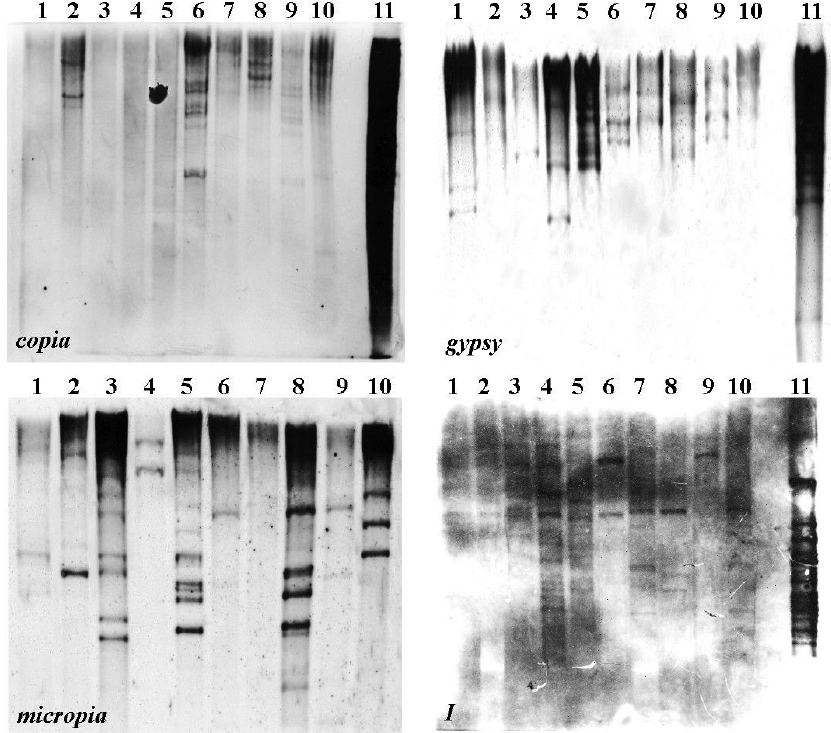
Figure 1 - Southern blot analysis of the retrotransposons copia , gypsy , micropia and I in D. neocordata (1); D. emarginata (2); D. parasaltans (3); D. subsaltans (4); D. milleri (5); D. dacunhai (6); D. sturtevanti (7); D. austrosaltans (8); D. saltans (9); D. prosaltans (10) and D. melanogaster (11).